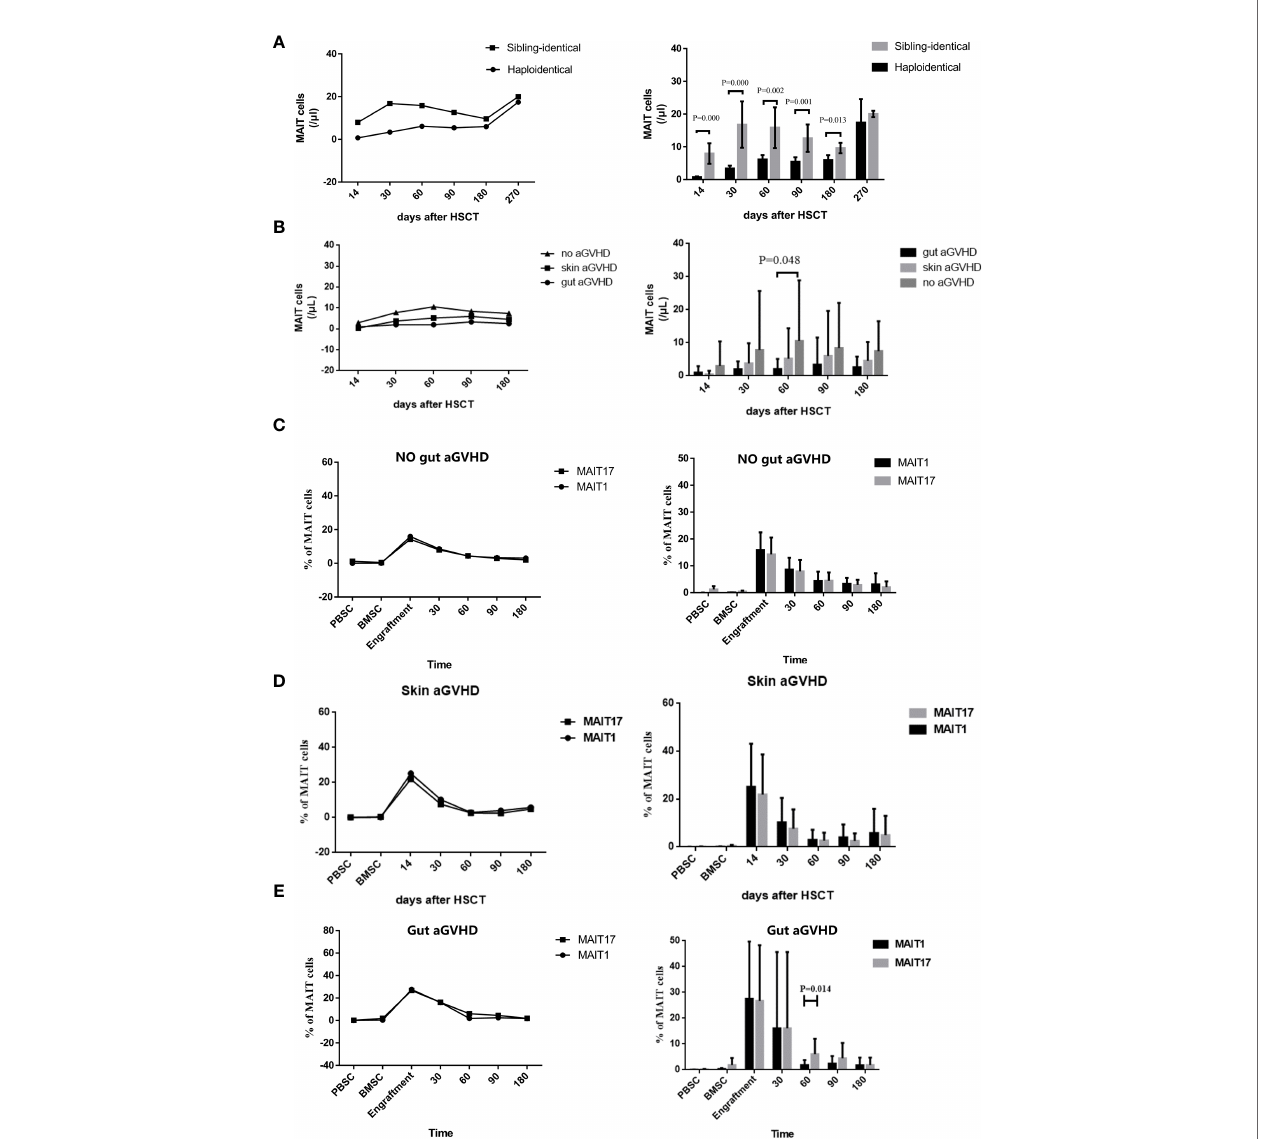
FIGURE 3 | Reconstitution of mucosa-associated invariant T (MAIT) cells and their different subgroups in the peripheral blood after transplantation. (A) Posttransplant number of MAIT cells reconstituted under haplo-hematopoietic stem cell transplantation (HSCT) and sibling-identical HSCT. (B) Posttransplant number of MAIT cells reconstituted in gut acute graft-versus-host disease (aGVHD) patients, skin aGVHD and no gut aGVHD patients. (C) Posttransplant reconstitution of MAIT1 and MAIT17 subsets based on the expression of transcription factors T-bet and Rorgt respectively in no gut aGVHD patients. (D) Posttransplant reconstitution of MAIT1 and MAIT17 subsets based on the expression of transcription factors T-bet and Rorgt respectively in skin aGVHD patients. (E) Posttransplant reconstitution of MAIT1 and MAIT17 subsets based on the expression of transcription factors T-bet and Rorgt respectively in gut aGVHD